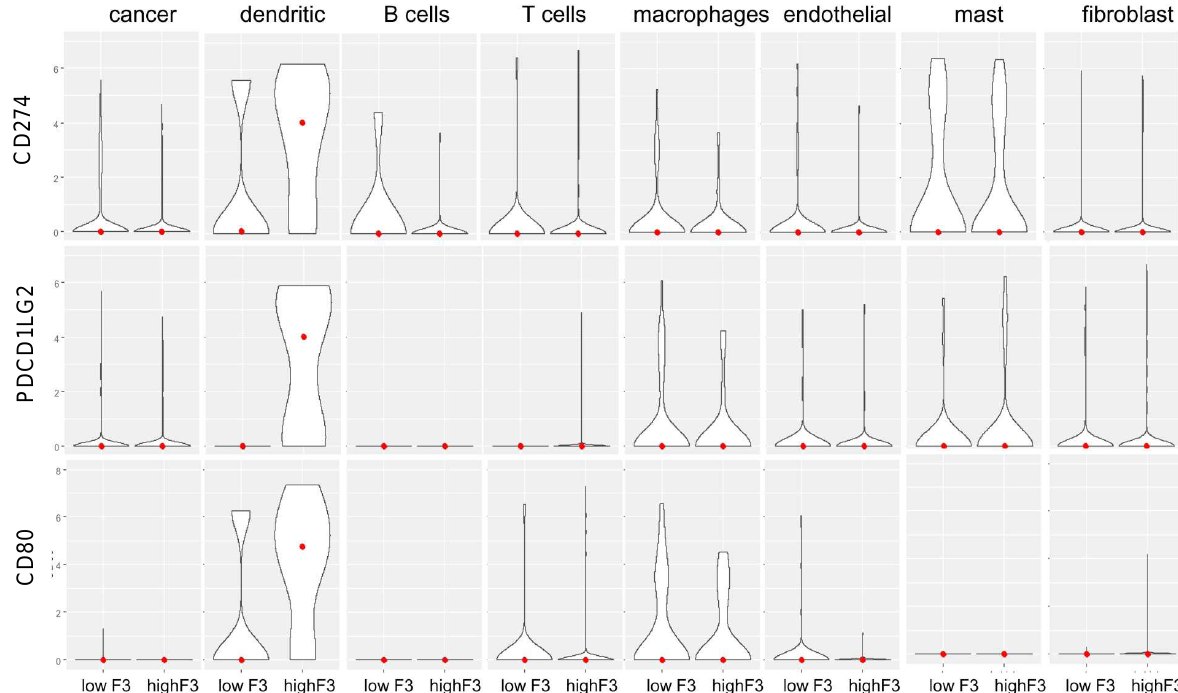
Figure 9. Single-cell analysis of the expression of immune checkpoint molecules in tumors stratified according to the expression of F3 in cancer cells. Violin plots showing the expression of CD274 /PD-L1, PDCD1LG2 /PD-L2 and CD80 in the different cell populations from the GSE103322 cohort, including cancer cells, B cells, T cells, macrophages, endothelial cells, fibroblasts, dendritic cells, mast